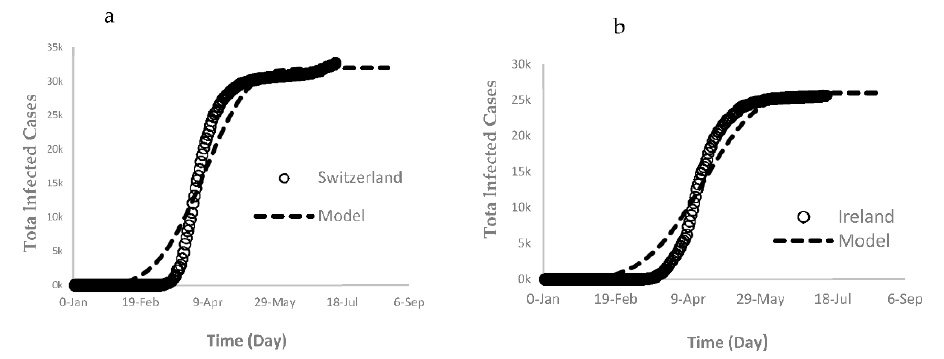
Figure 12. Logistic function regression fit of the total COVID-19 infected cases of Group A countries ( a ) Switzerland and ( b ) Ireland.